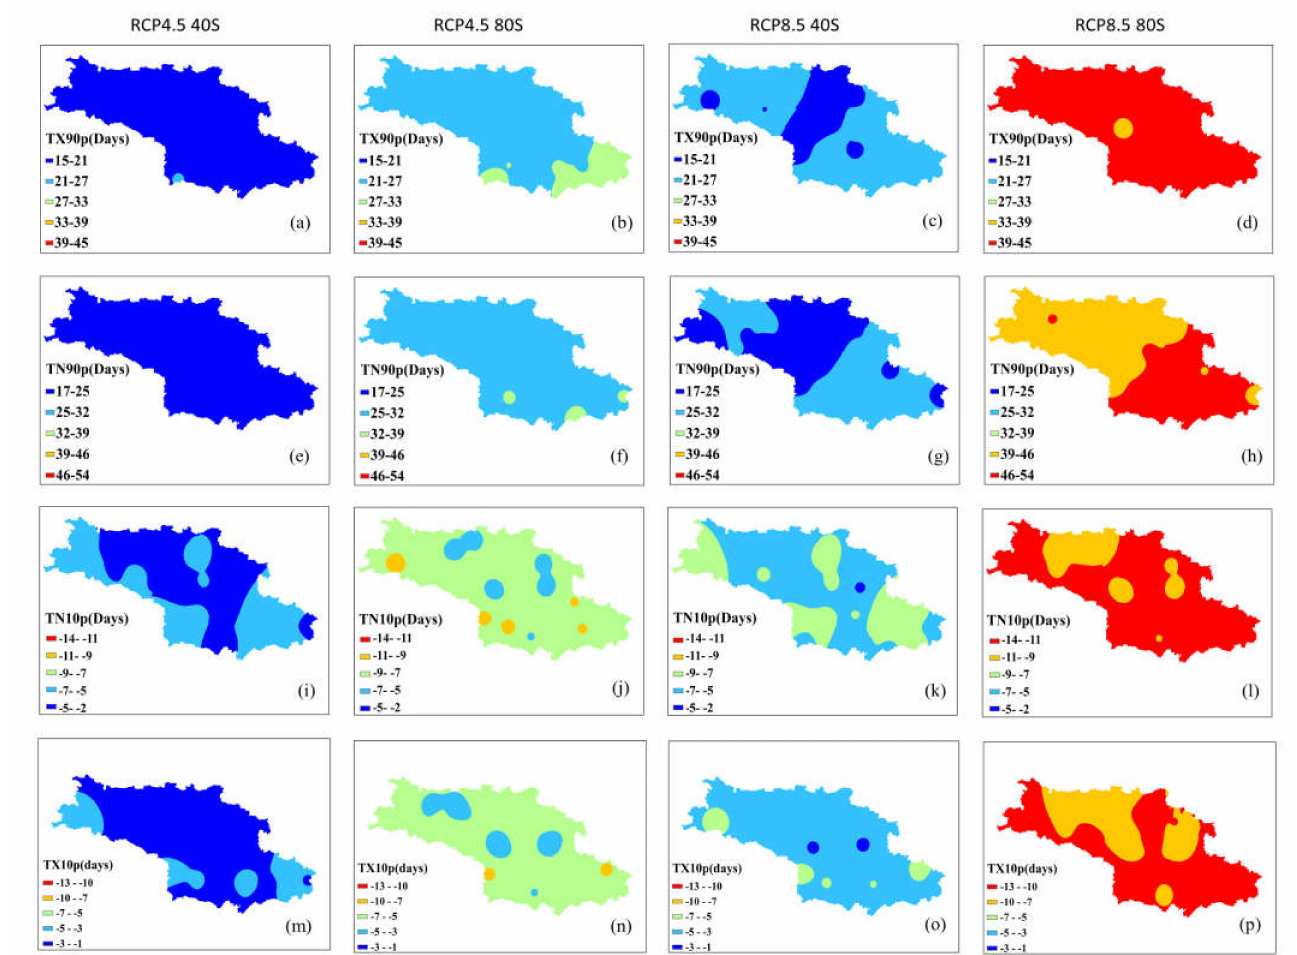
Figure 4. The spatial distribution of changes in the multi-model ensemble for the four percentile-based indices (TX90p, a – d ; TN90p, e – h ; TN10p, i – l ; TX10p m – p )during the 2040s and 2080s under two scenarios relative to 1971–2010 across the Han River